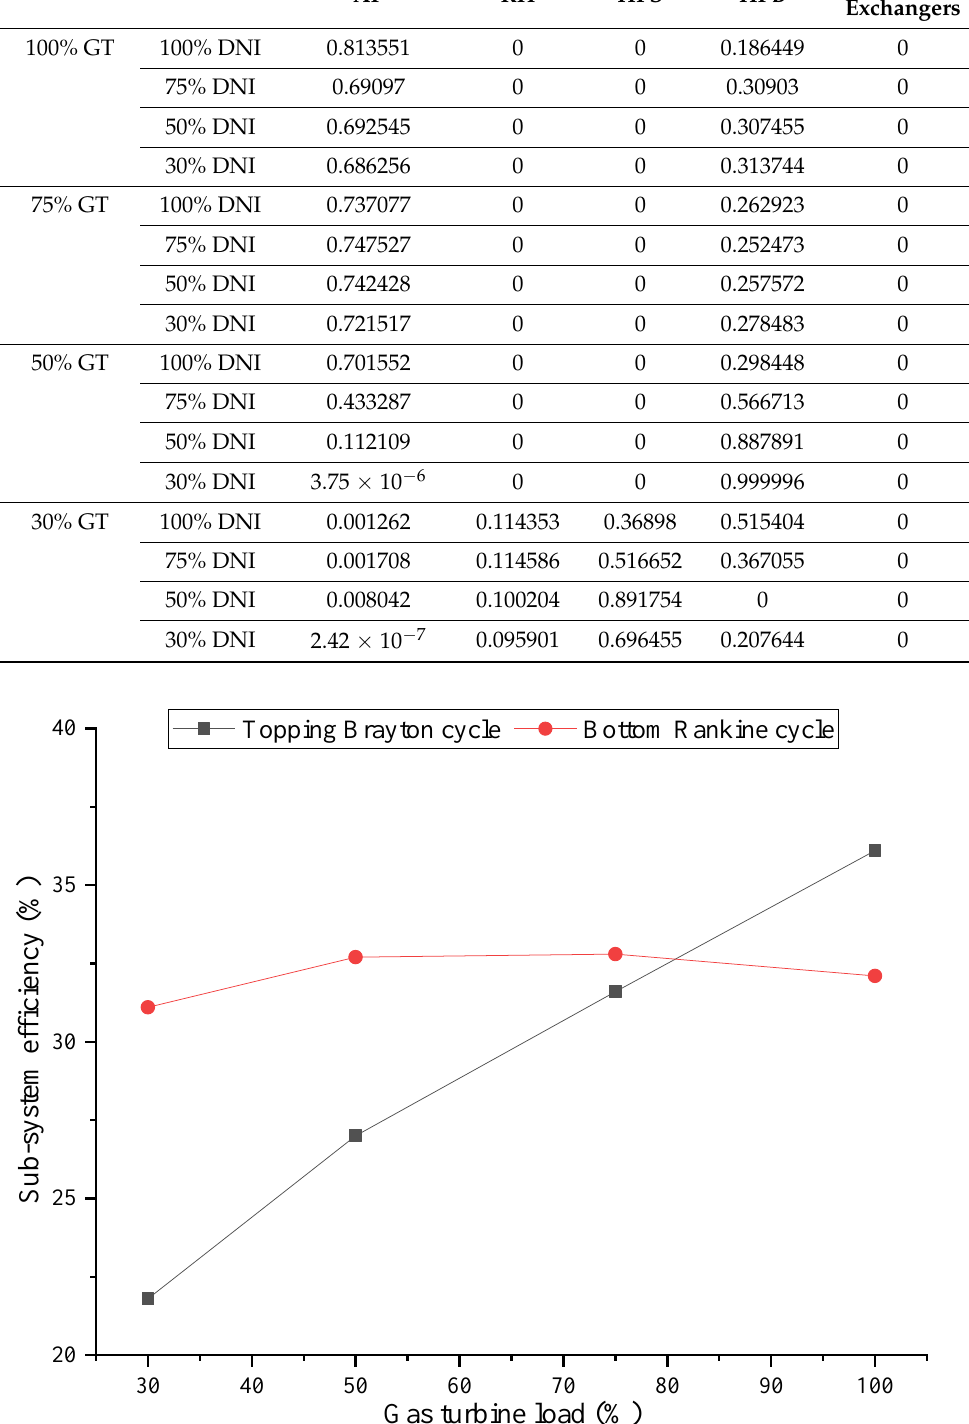
Figure 5. Trend of topping/bottom cycle efficiency with GT load reduction in GTCC system. Whereas, for the operating conditions at 30% GT load, the integration position of the bottom cycle will be redistributed: most often, the heat collection energy is preferentially integrated in the HPS with the higher initial steam parameters, followed by the RH and HPB parts.